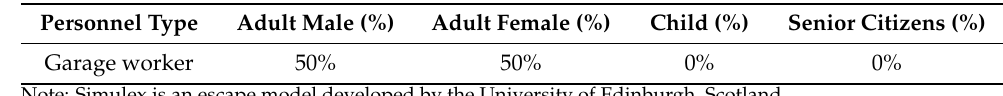
Table 8. Personnel type and composition.